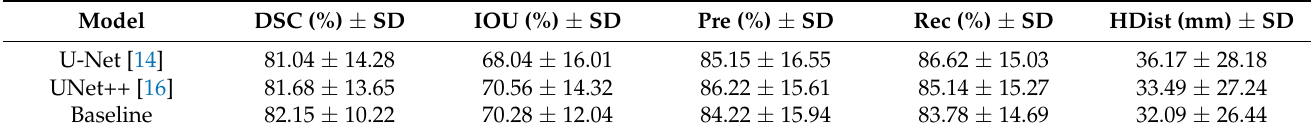
Table 2. Supervised segmentation performance